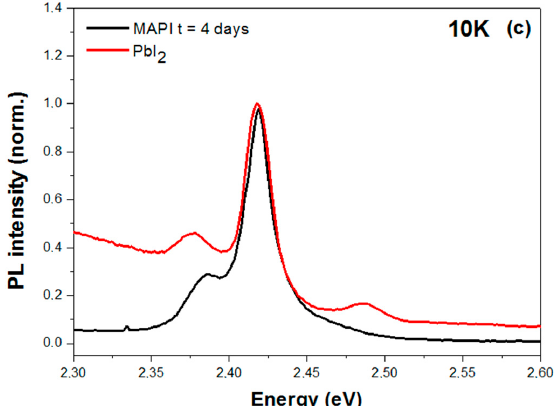
Figure 4. Absorption at room temperature ( a ); and ( b ) PL spectra at low temperature 10 K (excitation at 3.815 eV for the PL) of a 800 nm thick MAPI layer, at t = 0 day (blue line) and t = 4 days (black line). The bold line shows the spectra for MAPI* sample obtained with the powdered PbI 2 . The PL spectra have been normalized so that the maximum PL at 1.64 eV is 1; ( c ) PL spectra at 10 K in the 2.3–2.6 eV range of MAPI layer at t = 4 days and PbI 2 . The PL spectra have been normalized so that the maximum PL at 2.4 eV is 1.